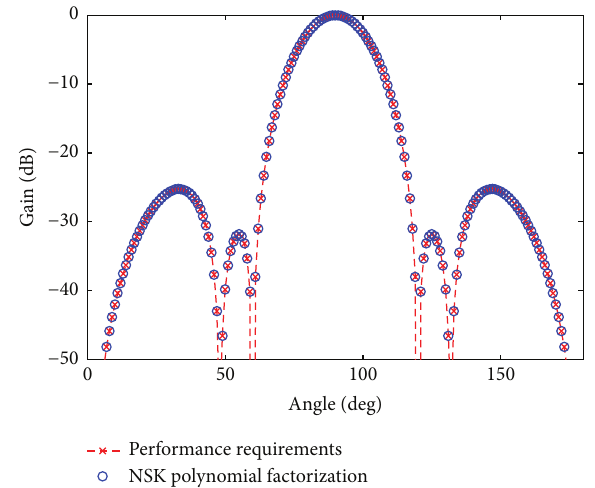
Figure 8: Comparison between NSK polynomial factorization and performance